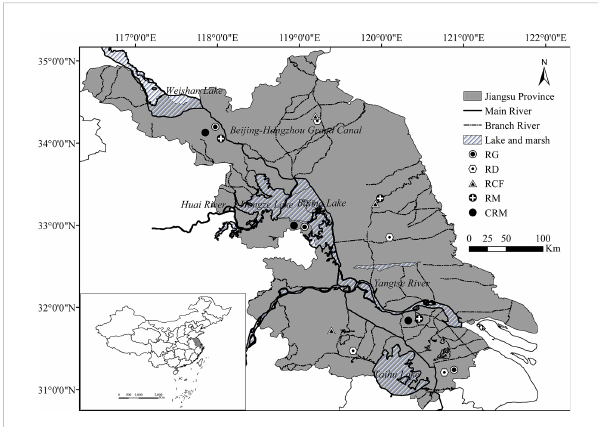
FIGURE 1 Survey sites of the fi ve rice production modes. RG, Rice-green manure rotation mode for organic rice production; RD, rice-duck coculture mode for organic rice production; RCF, rice-cray fi sh coculture mode for organic rice production; RM, rice monoculture mode for organic rice production; CRM, rice monoculture mode for conventional rice